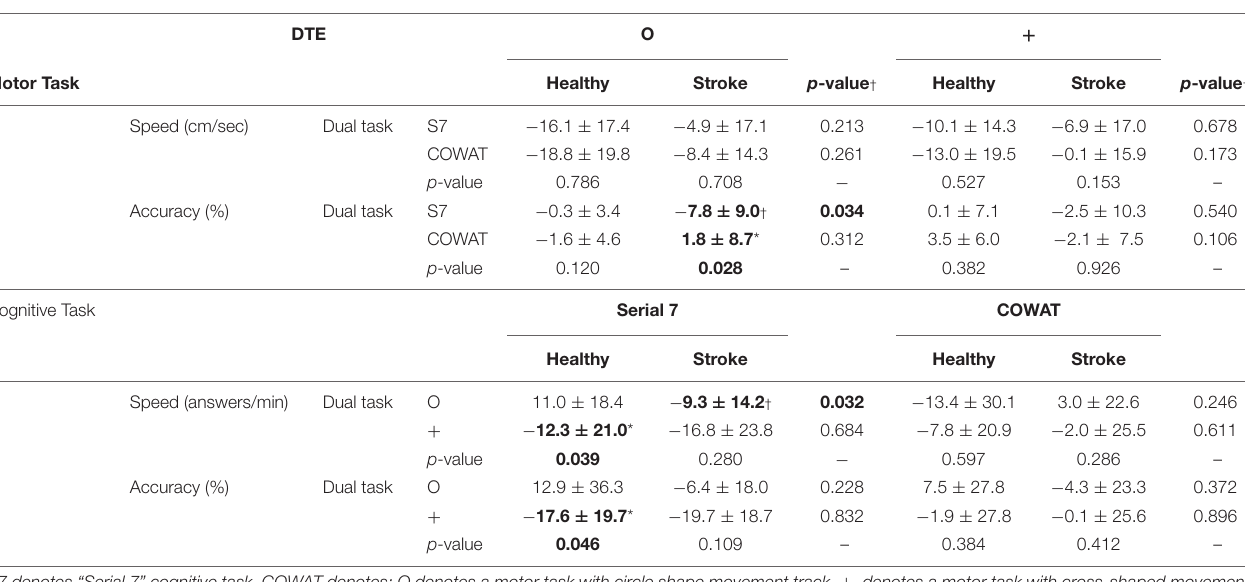
TABLE 3 | Dual Task Effects in Motor and Cognitive Tasks.